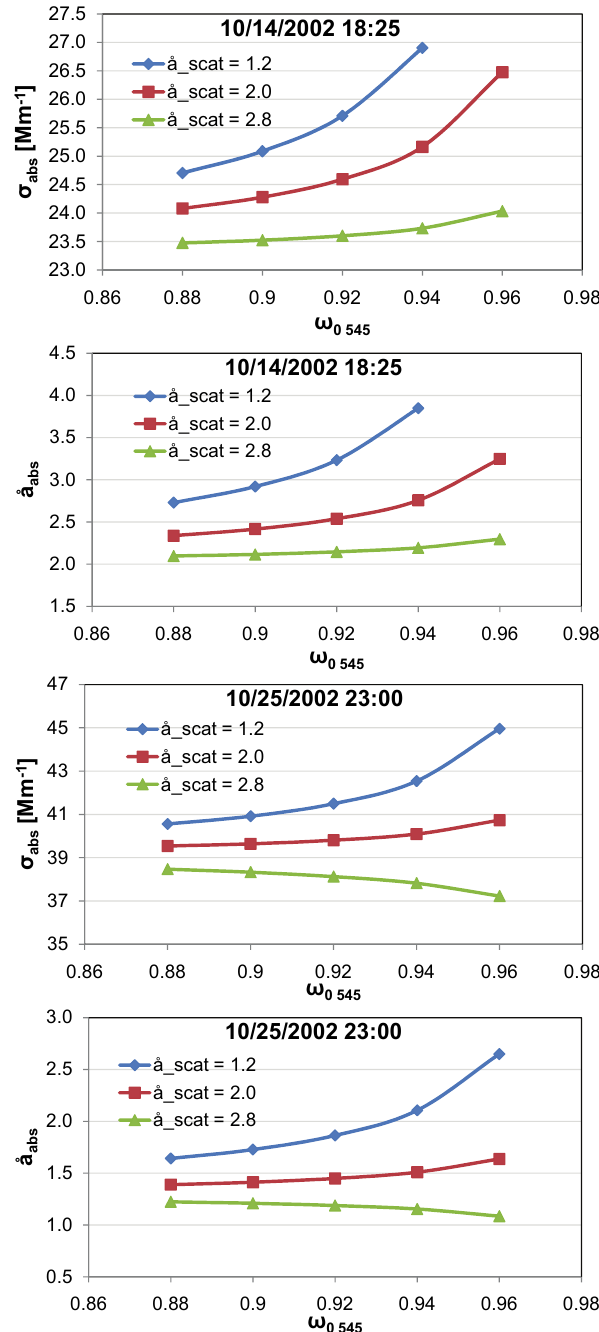
Fig. 2. Dependence of calculated σ abs and ˚a abs on ω 0 and ˚a scat for two attenuation spectra measured during the LBA/SMOCC exper- iment: (a) , (b) 14 October 2002 18:25; (c) , (d) 25 October 2002 23:00. The measured spectra had attenuation coefficients ( σ ATN ) at 450nm of 102 and 179Mm − 1 , respectively, and attenuation ˚Angstrom exponents ( ˚a ATN ) of 1.72 and 1.04,